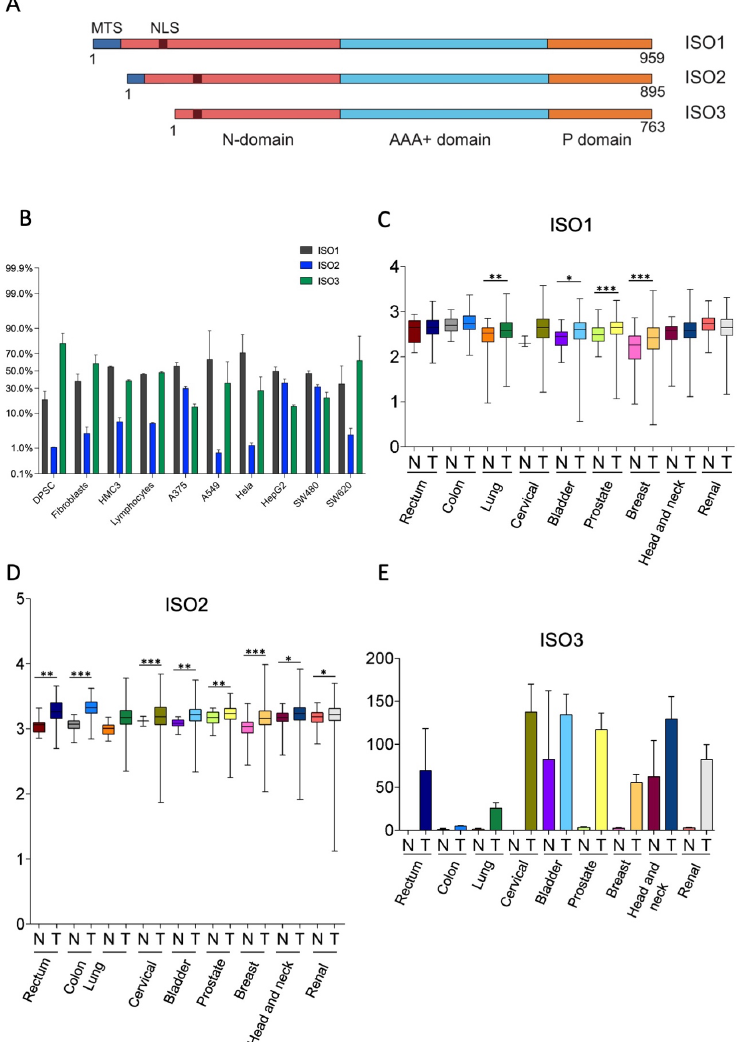
Figure 1. Human cells express three isoforms of Lonp1. ( A ). Diagram depicting the location of mitochondrial targeting sequence (MTS), of the nuclear localization signal (NLS), and of the N, AAA+ and P domains of three isoforms of human Lonp1. The length of the three isoforms is indicated. ( B ). Histogram showing the percentage of Lonp1 isoform-1 (ISO1), Lonp1 isoform-2 (ISO2), and Lonp1 isoform-3 (ISO3) mRNA expression in primary cells (DPSC, dental pulp stem cell; Fibroblasts; HMC3, human microglial cell; Lymphocyte) and cancer cell lines (A375, melanoma; A549, lung cancer; Hela, human cervix epitheloid carcinoma; HepG2, hepatocellular carcinoma; SW480, non- metastatic colon adenocarcinoma; SW620, metastatic colon adenocarcinoma) of different origins. Data represent the mean ± SD. ( C–E ). Relative expression levels of Lonp1 ISO1, ISO2, and ISO3 mRNA in the indicated primary solid tumours (T) and the normal (N) counterparts, as obtained from TGCA Splicing Variant database (TSVdb). Rectum: rectum adenocarcinoma; Colon: colon adenocarcinoma; Lung: lung adenocarcinoma; Cervical: cervical squamous cell carcinoma and endocervical carcinoma; Bladder: bladder urothelial carcinoma; Prostate: prostate adenocarcinoma; Breast: breast invasive carcinoma; Head and neck: head and neck squamous cell carcinoma; Renal: renal clear cell carcinoma. Data are in log scale; mean, 24 and 75 percentile, max and min values are shown. Data for ISO3 are in linear scale and expressed as mean ± SD * = p < 0.05; ** = p < 0.01; *** = p <